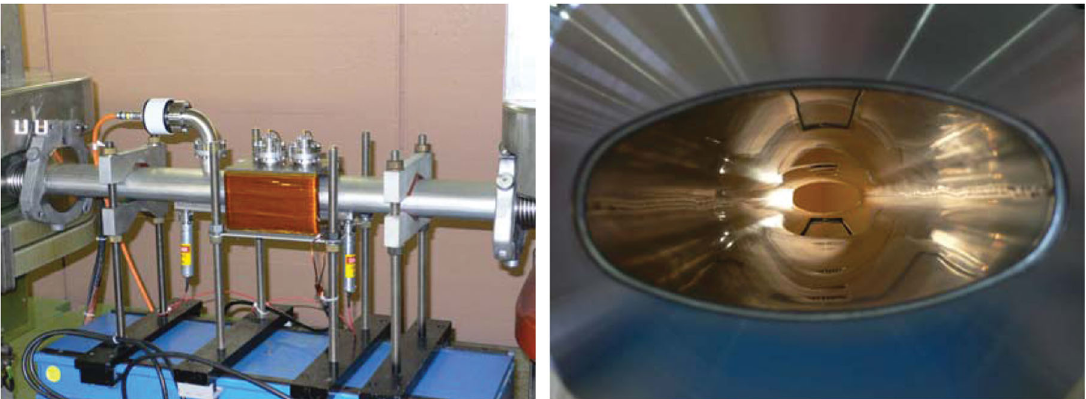
FIG. 2. (Color) Left: Picture of the new electron cloud experiment installed in PS straight section 98, containing two shielded button pickups, a shielded Penning gauge, a clearing electrode, and a small dipole magnet. Right: Downstream view into the vacuum chamber showing the stripline electrode at the